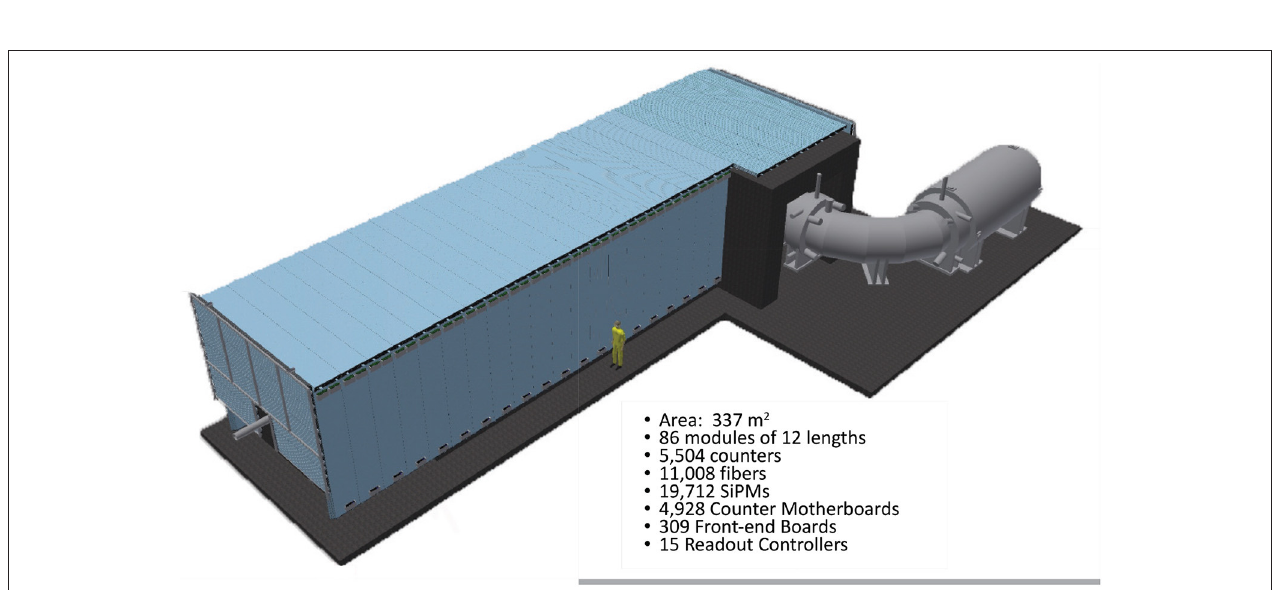
FIGURE 16 | The Mu2e CRV system, showing the coverage and scale. The Production Solenoid is to the right; the system covers the Detector Solenoid and part of the Transport Solenoid. From Bartoszek et al. [8].